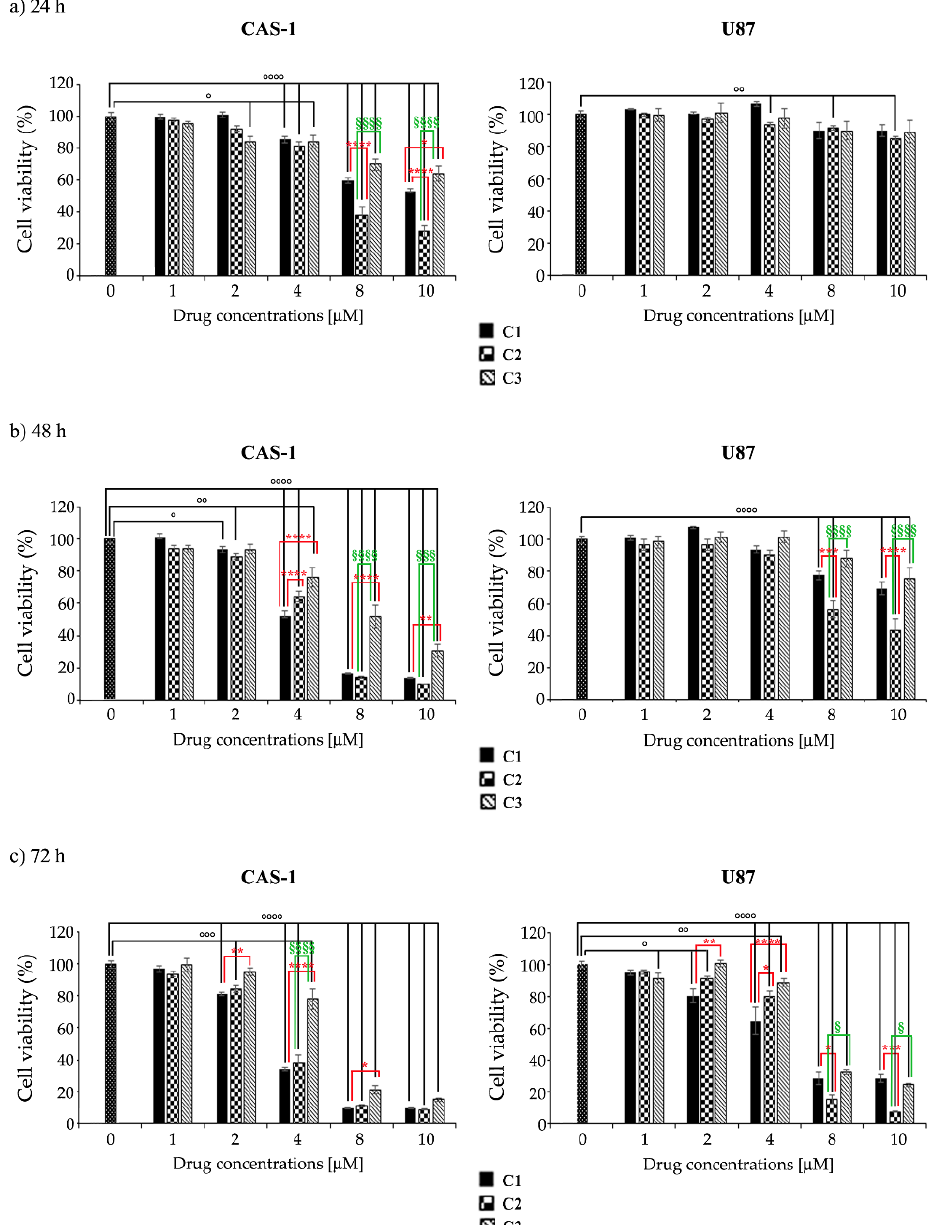
Figure 3. U87 cells are less sensitive than CAS1 to the anti-survival effect of SI306- and SI306-derived drugs. CAS-1 (left panels) and U87 (right panels) cells were exposed to increasing concentrations (1–10 µ M) of compound 1 (C1, SI306), compound 2 (C2), and compound 3 (C3) for 24 h ( a ), 48 h ( b ), and 72 h ( c ). Cell viability was evaluated by MTS assay. Histograms summarize quantitative data of the means ± S.E.M. of five independent experiments. Statistical significance of differences was determined by ANOVA followed by Tukey’s test. ◦ p < 0.05 vs. untreated cells; ◦◦ p < 0.01 vs. untreated cells; ◦◦◦ p < 0.001 vs. untreated cells; ◦◦◦◦ p < 0.0001 vs. untreated cells; * p < 0.05 vs. compound 1 ; ** p < 0.01 vs. compound 1 ; *** p < 0.001 vs. compound 1 ; **** p < 0.0001 vs. compound 1 ; § p < 0.05 vs. compound 2 ; §§§ p < 0.001 vs. compound 2 ; and §§§§ p < 0.0001 vs. compound 2